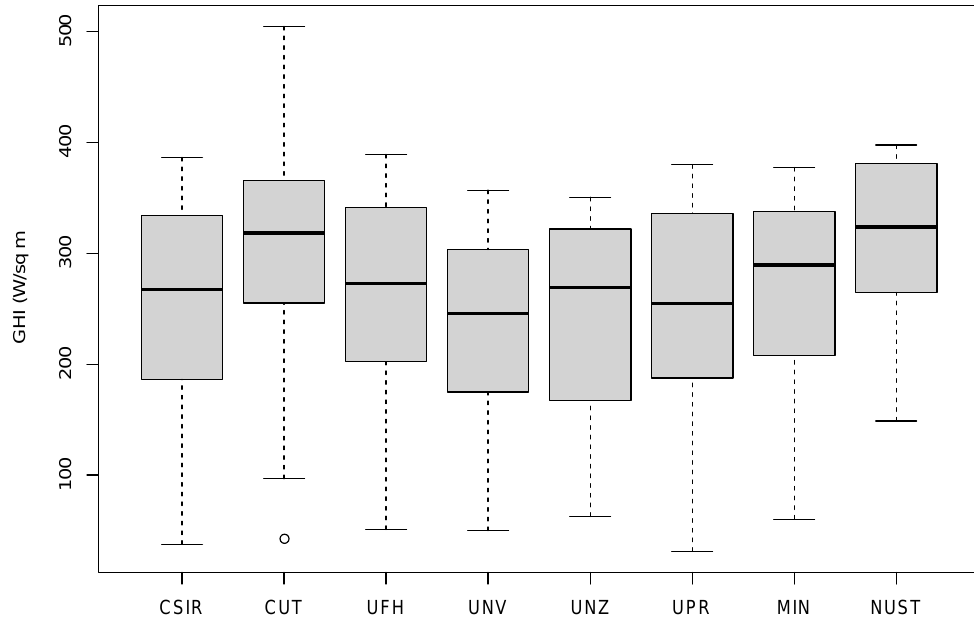
Figure 5. Box plots of GHI at the eight radiometric stations.